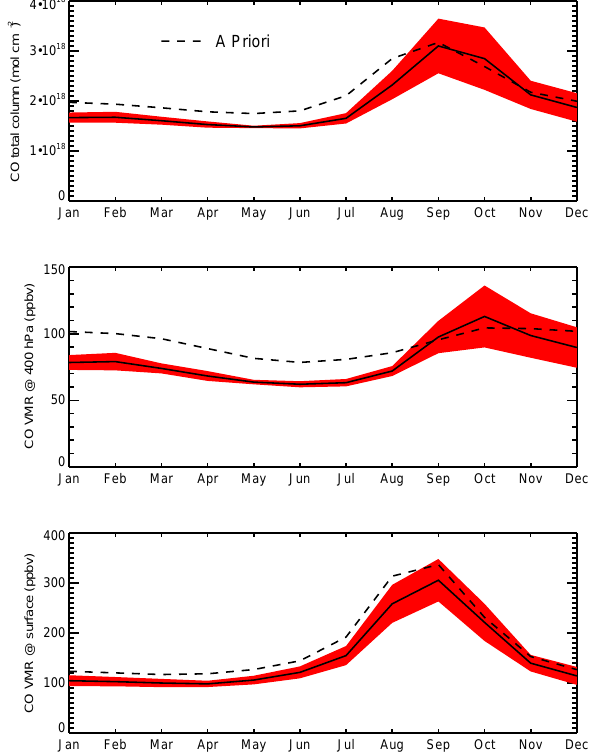
Figure 9. MOPITT TIR-NIR long-term monthly means of retrieved CO total column and CO concentrations for the Amazon Basin, based on observations from 2002 to 2015. Shaded red area indicates variability (standard deviation) of monthly means. Monthly-mean a priori values are also indicated for